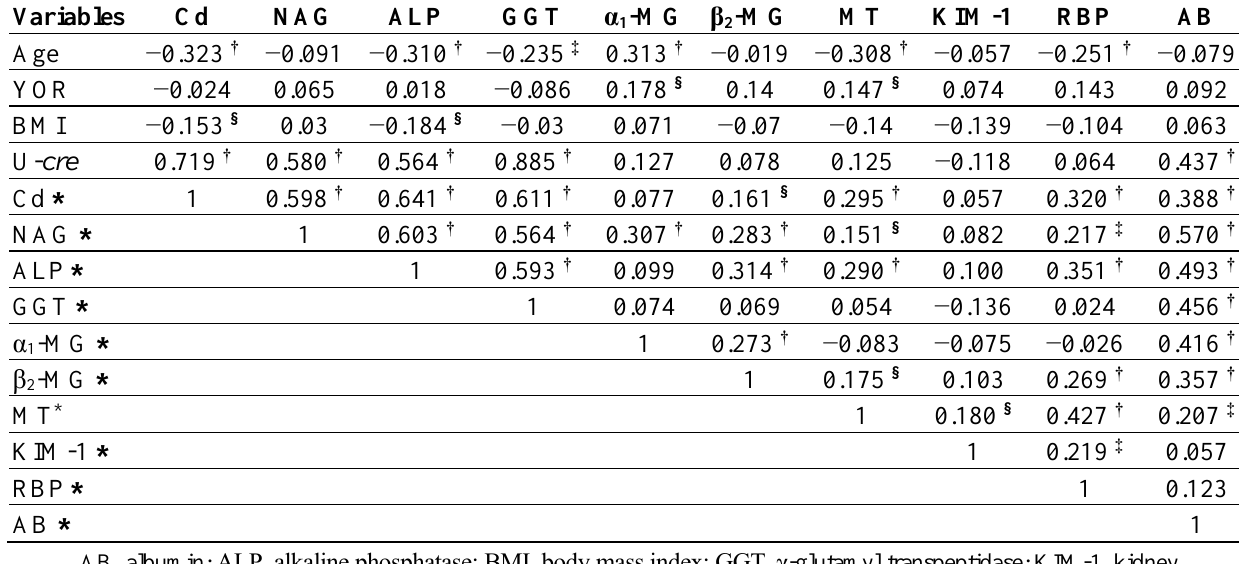
Table 3. Spearman’s rank correlation based on observed